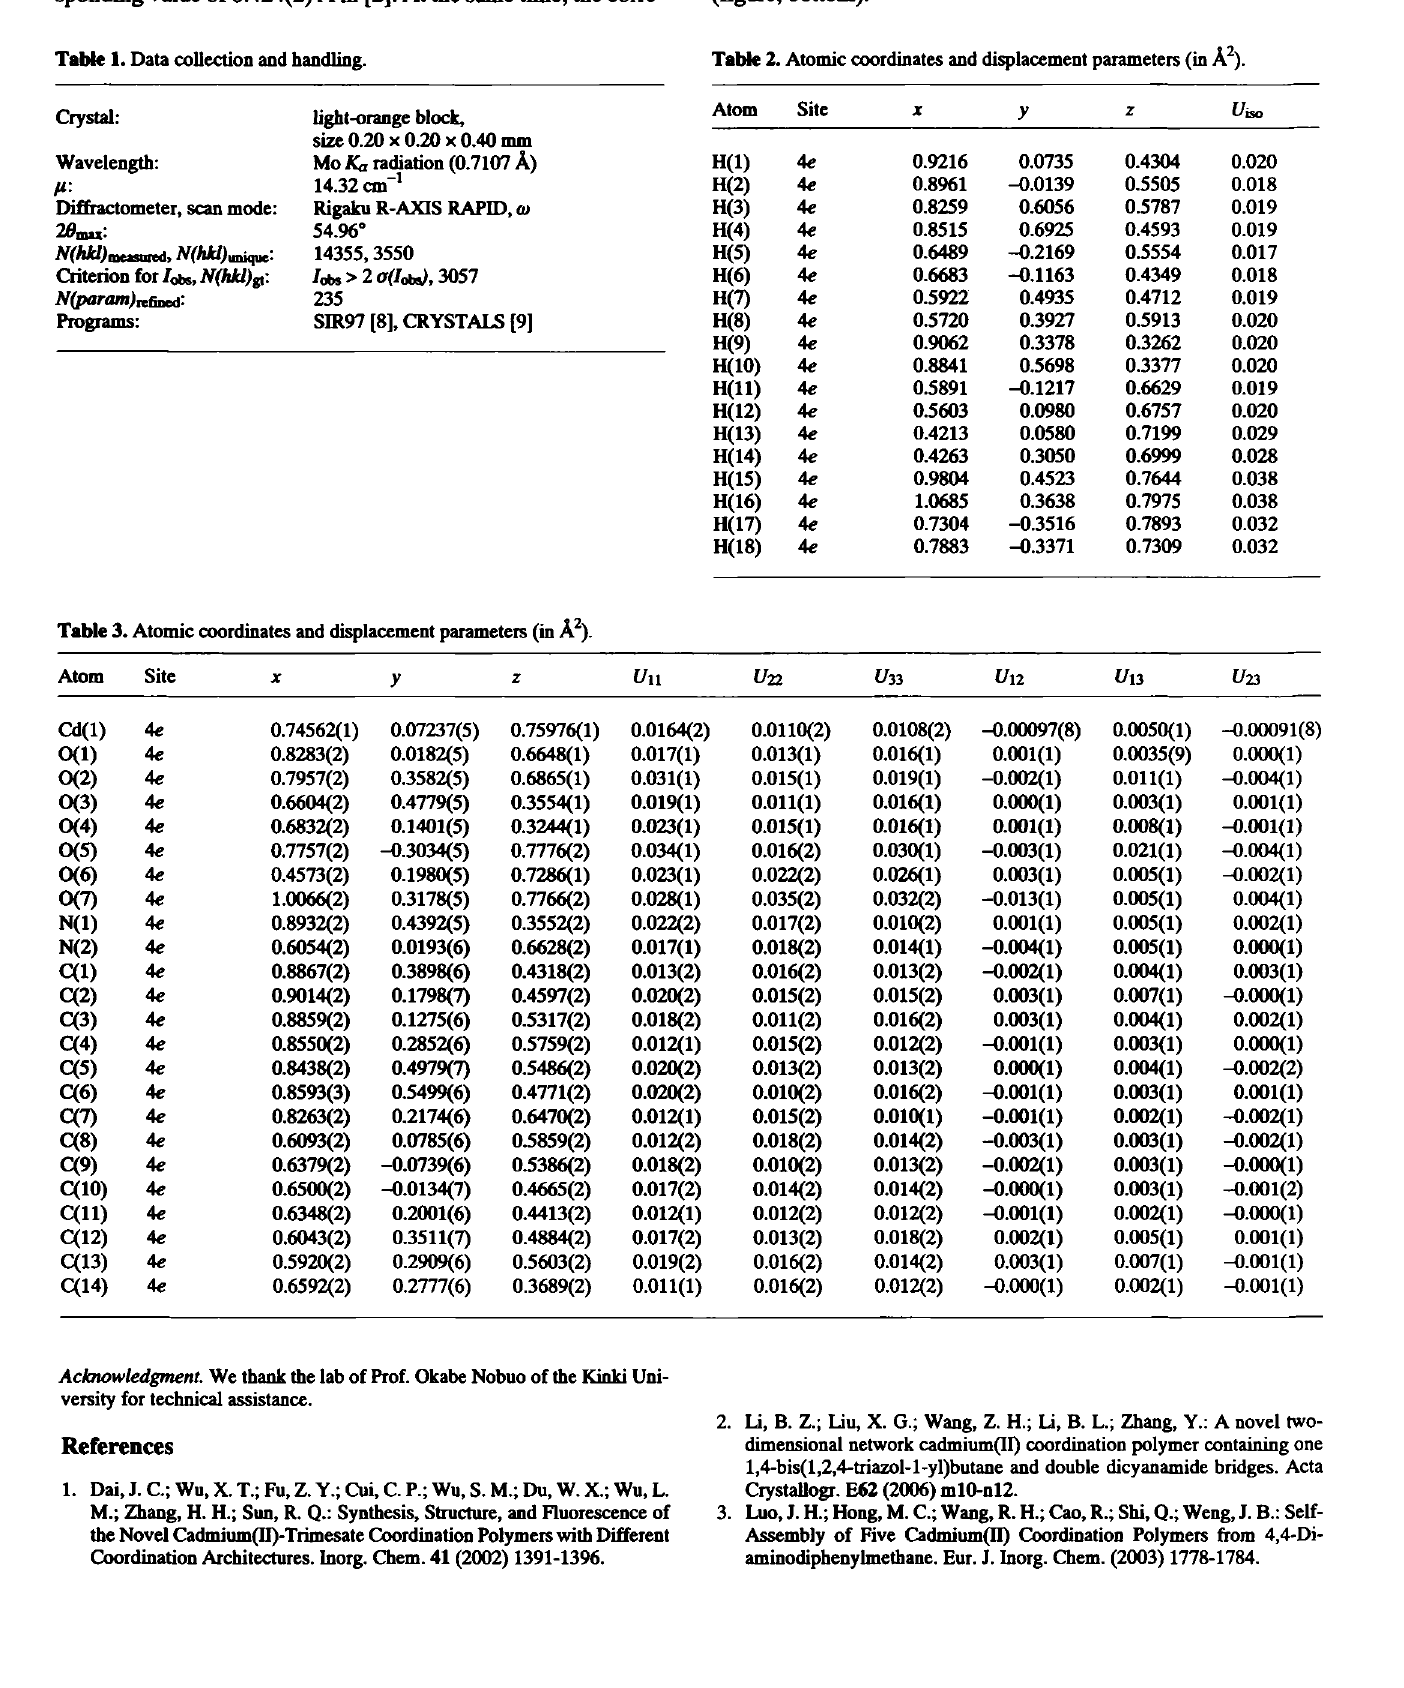
Table 1. Data collection and handling. Table 2. Atomic coordinates and displacement parameters (in Ä 2 ).